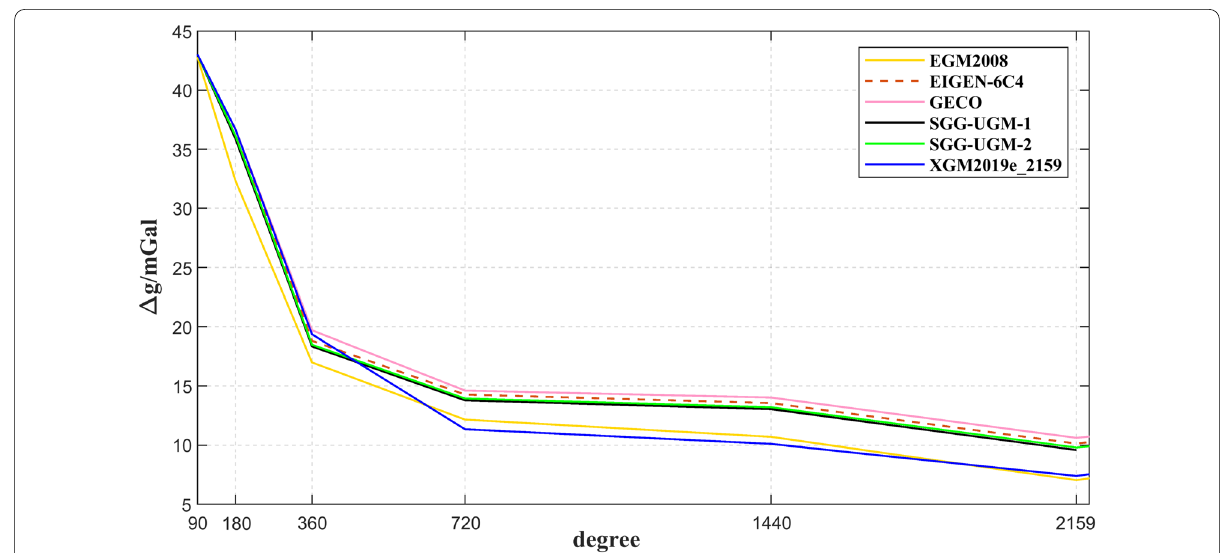
Fig. 4 The standard deviation of differences in Sichuan